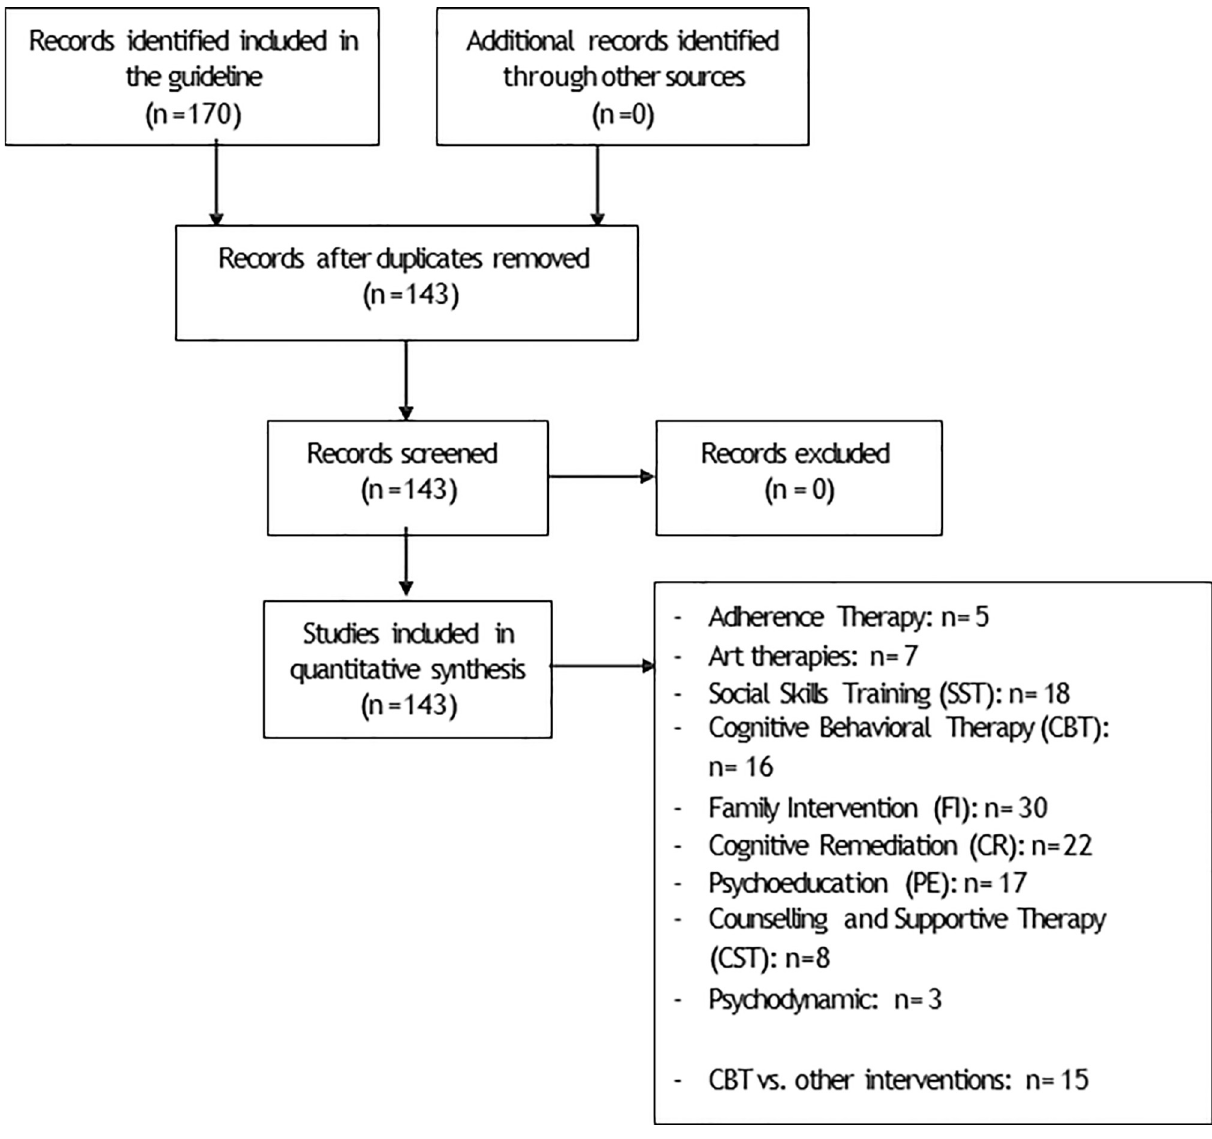
Fig 1. PRISMA flow